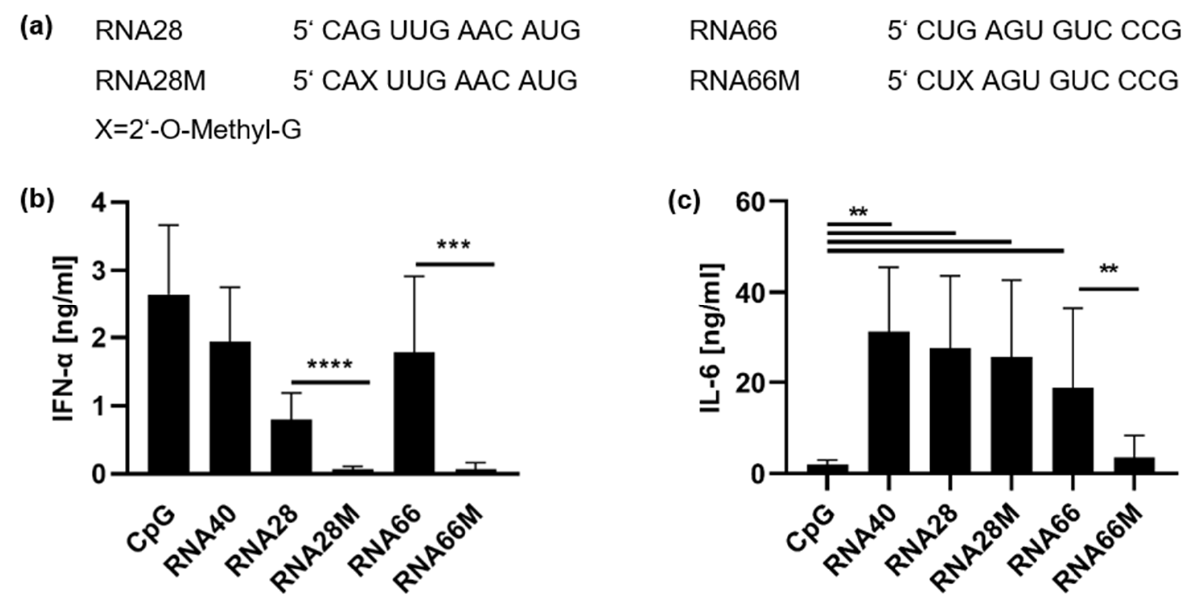
Figure 3. Impact of 2′-O-ribose methylation on cytokine induction by naturally methylated and un- methylated sequences. ( a ) Sequences of applied RNA derivatives. 2′-O-ribose methylated guanosine are indicated with an X. ( b , c ) PBMCs were stimulated with RNA66 or RNA28 derivatives at a final concentration of 10 µg/mL, with 1 µM CpG ODN 2216 or 5 µg/mL RNA40. Supernatants were harvested 20 h p. s. and both ( b ) IFN-α and ( c ) IL-6 concentrations were measured by ELISA. Graphs depict six independent experiments with PBMCs obtained from six individual healthy donors each in biological duplicates (twelve measurements per data point, mean + S.D). Data were analyzed using paired t-tests; IL-6-data of RNA66 and RNA66M were analyzed using Wilcoxon tests. **** p < 0.0001, *** p < 0.001, ** p <